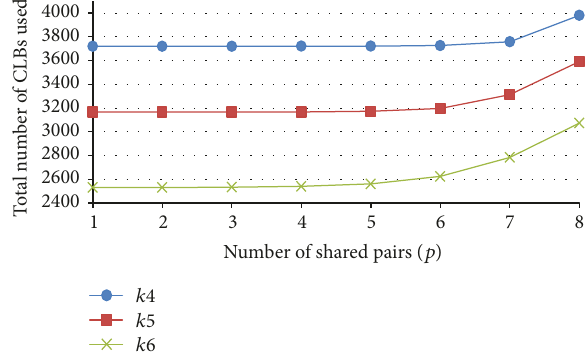
Figure 8: Number of CLBs utilized for cluster size of 𝑁 = 16 and 𝑝 =